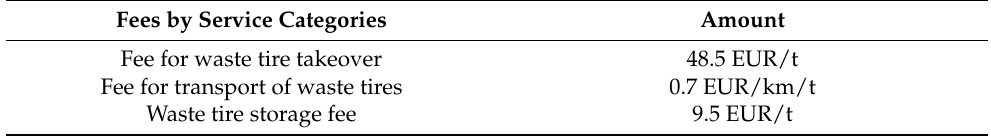
Table 5. Unit fees 1 by service